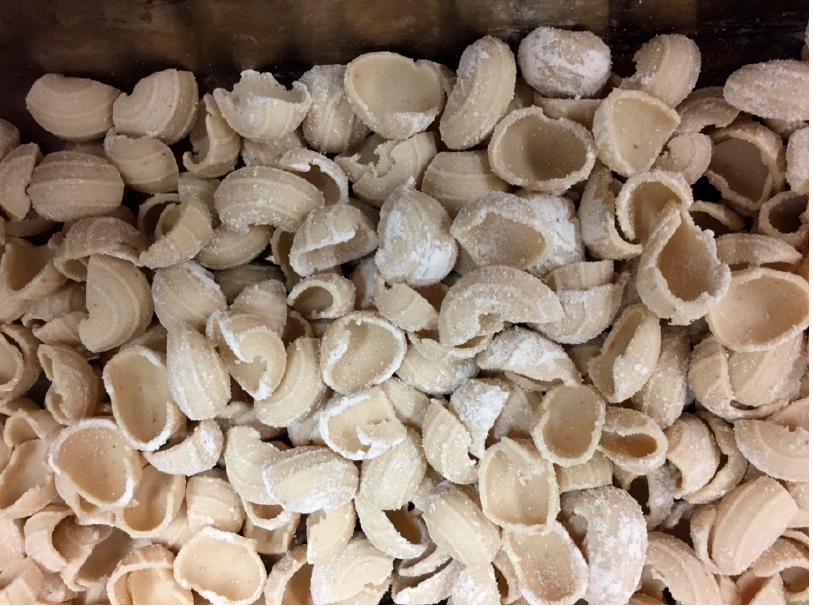
Figure A1 . Breadfruit pasta (Orecchiette). Photo© Carmen L. Nochera . Figure A1. Breadfruit pasta (Orecchiette). Photo© Carmen L.